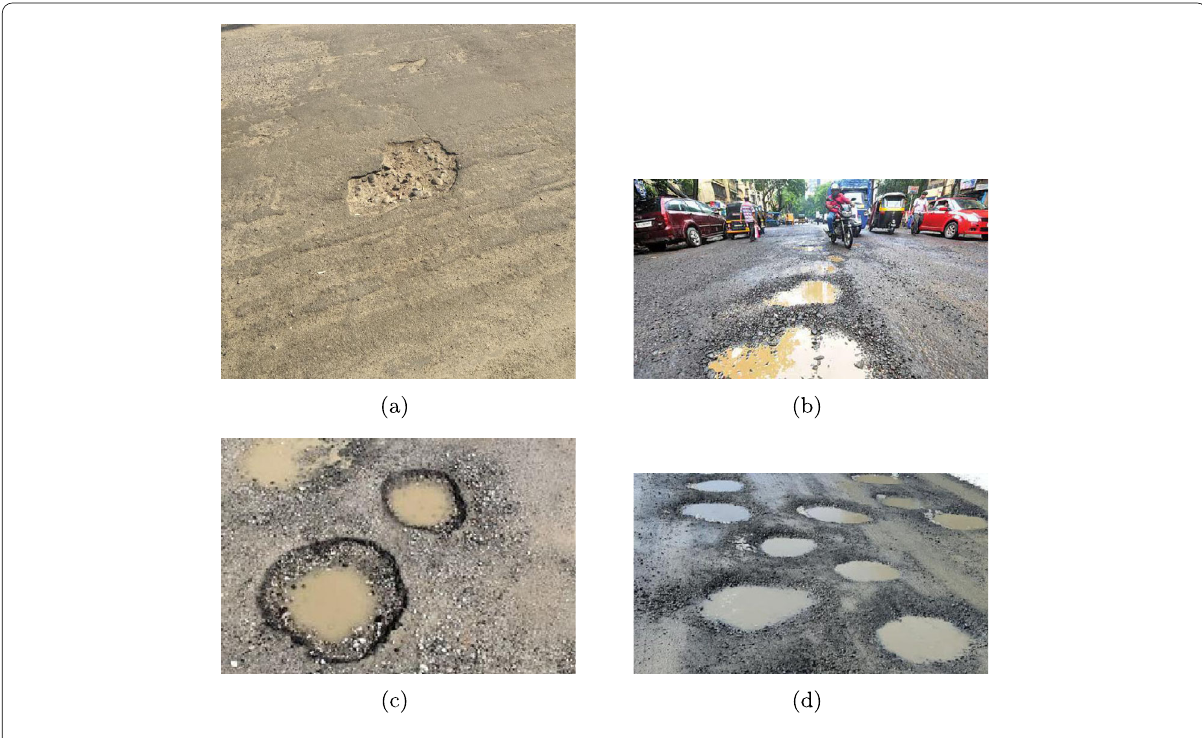
Figure 1 Sample pothole images used for training and testing the